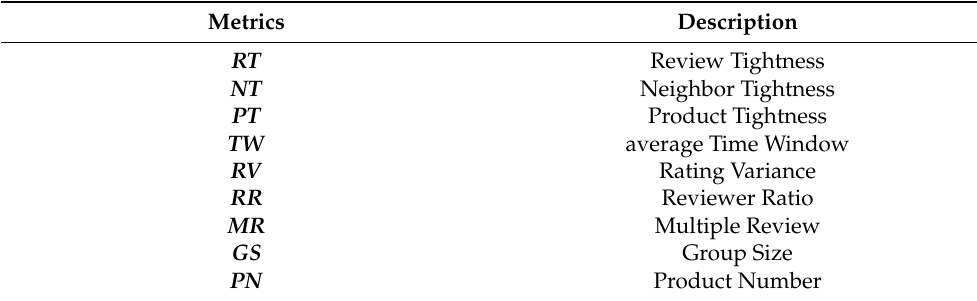
Table 2. Collusive Group Evaluation